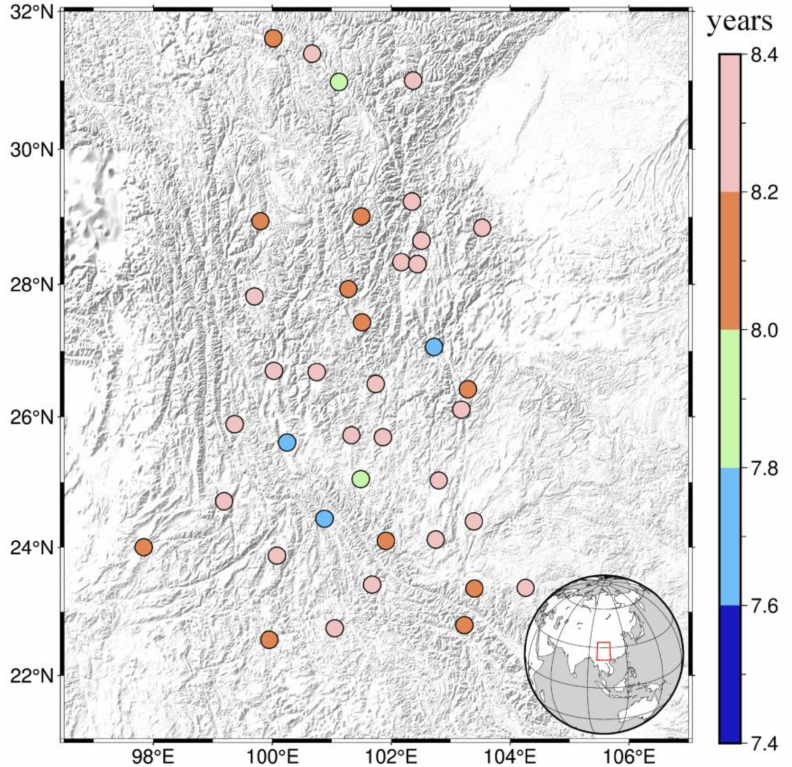
Figure 1. Spatial distribution and data availability of 39 GNSS stations in the Chuandian